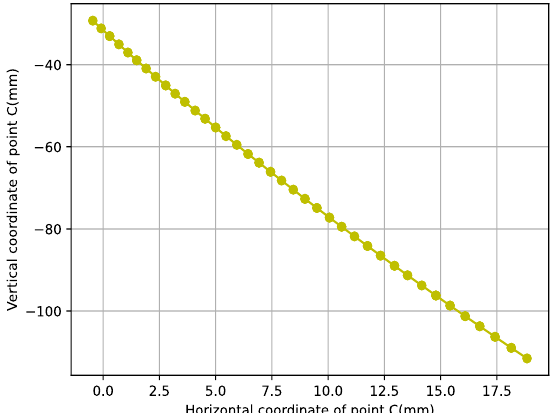
Figure 10. Coordinate change curve of point C.